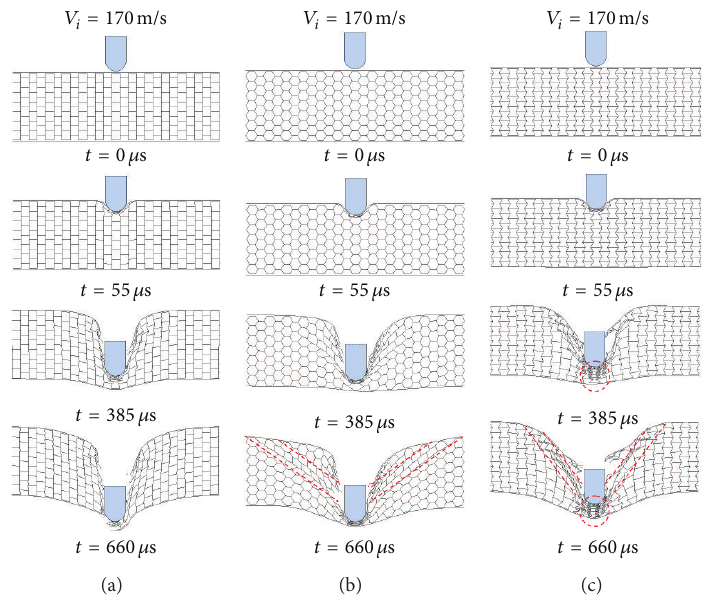
Figure 7: Impact processes of (a) R-type, (b) H-type, and (c) A-type HSPs by the projectile at 𝑉 𝑖 = 170